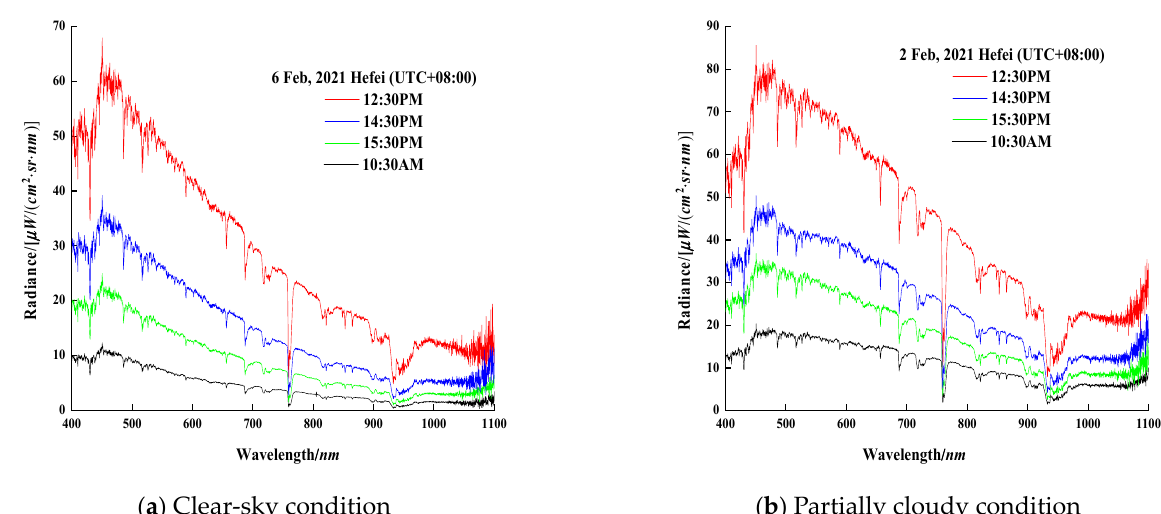
Figure 17. Fixed-point spectral radiance for two days in